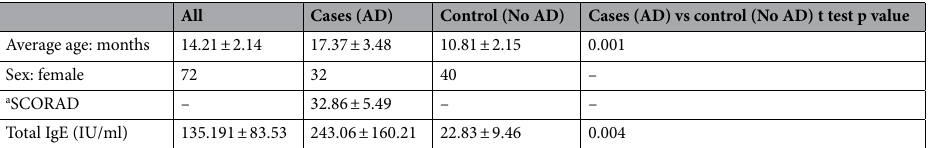
Table 1. Baseline characteristics of the subjects in this study. a SCORAD: SCOring AD value, an AD assessment index that is only available for patients.